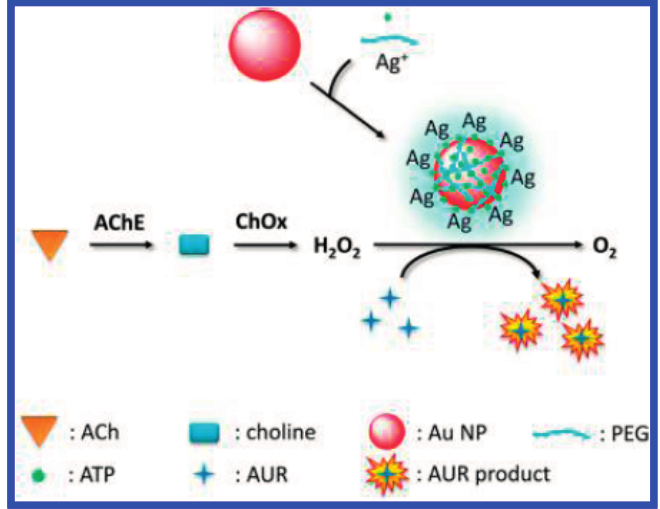
Figure 8. Schematic representation of the sensing strategy of the fluorescent assay using Au/Ag NPs to detect ACh. Reprinted with permission from [20]. Copyright 2012 American Chemical